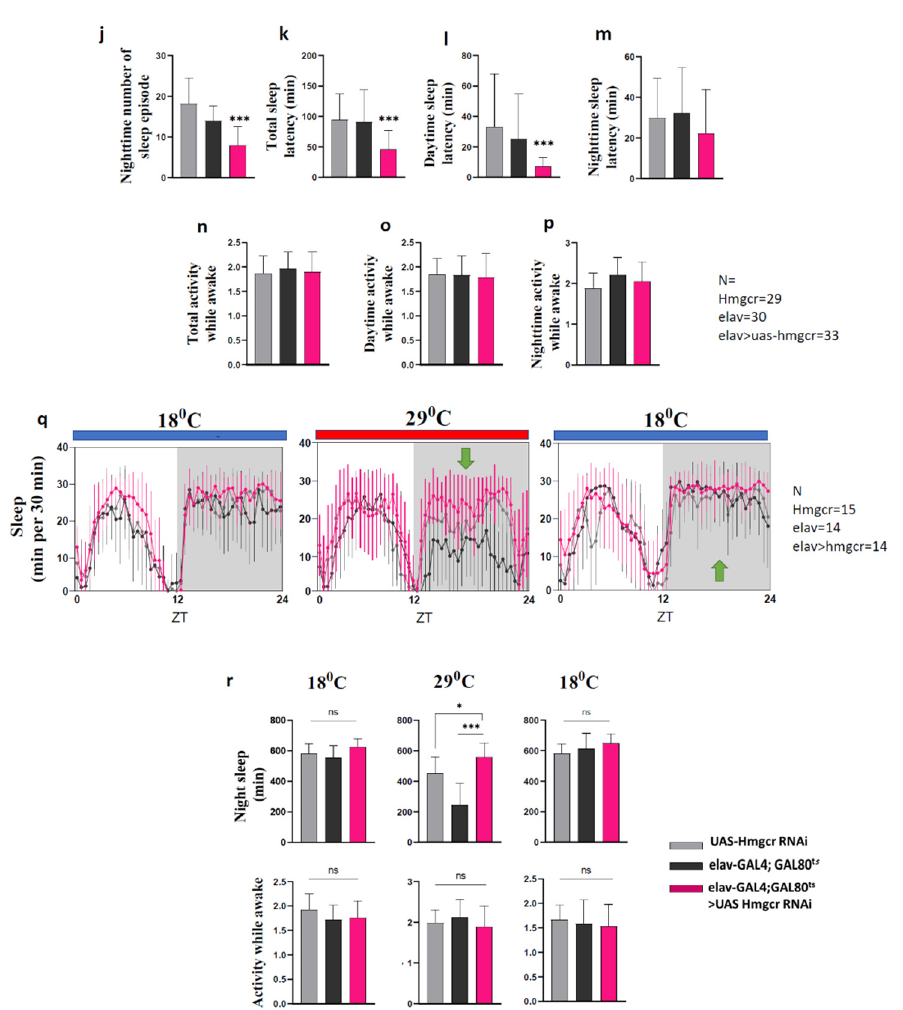
Figure 1. Loss of pan-neuronal Hmgcr in male flies has sleep-promoting effects. ( a ) Sleep diagram per 30 min, ( b – q ) total sleep duration, mean and max sleep episode duration, number of sleep episodes, sleep latency, and activity while awake between control groups ( elav-GAL4 \ + and UAS-Hmgcr RNAi \ +) and the experimental group ( elav-GAL4 > UAS-Hmgcr RNAi) have significant differences. All error bars represent ± S.D. For each genotype, n = 32 male flies. ( r ) The transgene tubGAL80 ts was used to control the expression of UAS-Hmgcr RNAi in the elav-GAL4 neurons. At 18 ◦ C, the GAL80 ts blocks the expression of UAS-Hmgcr RNAi. At 29 ◦ C, the GAL80 ts protein was inactivated, allowing the expression of UAS-Hmgcr RNAi driven by the elav-GAL4 . Transient knockdown of Hmgcr expression by pan-neuronal ( elav-GAL4 ) caused a significant increase in night sleep (green arrows). After the GAL80 ts protein was reactivated at 18 ◦ C, the increased sleep was reversible and immediately returned to normal (green arrows). All measurements are calculated from the number of beam crossings per minute. In all graphs, error bars indicate ± S.D. For each group n = 32 male flies. To detect the significant difference between groups a Shapiro–Wilk test was performed to determine normality, then a one-way ANOVA and Bonferroni post hoc test was performed. * p < 0.01, *** p <